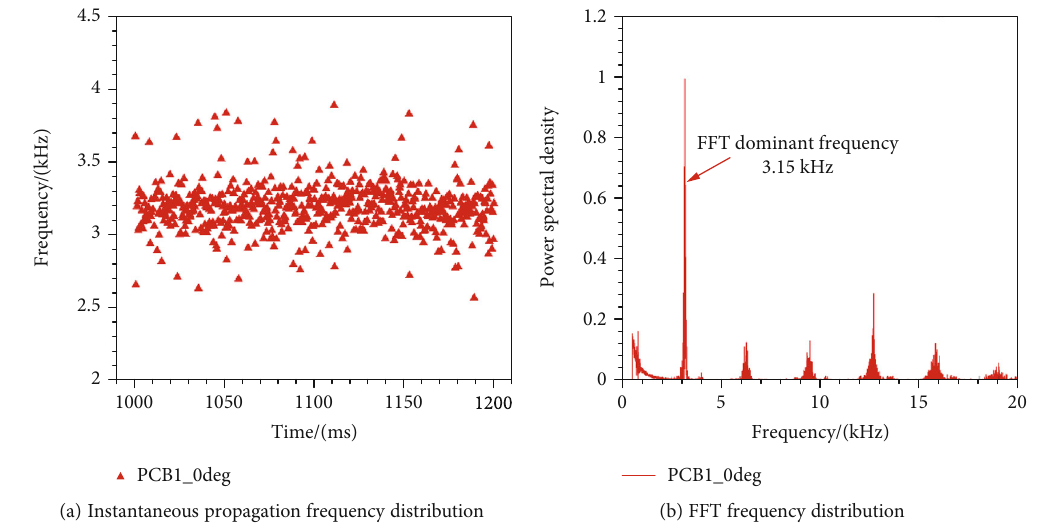
Figure 5: Propagation frequency of Test